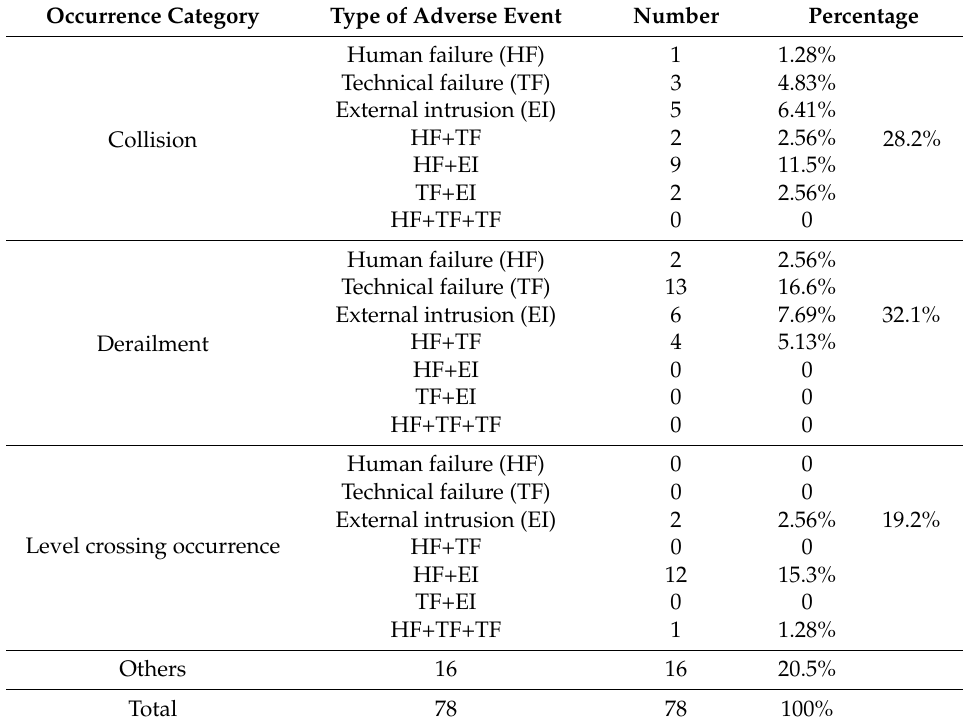
Table 1. Numbers and percentages of train accidents and adverse